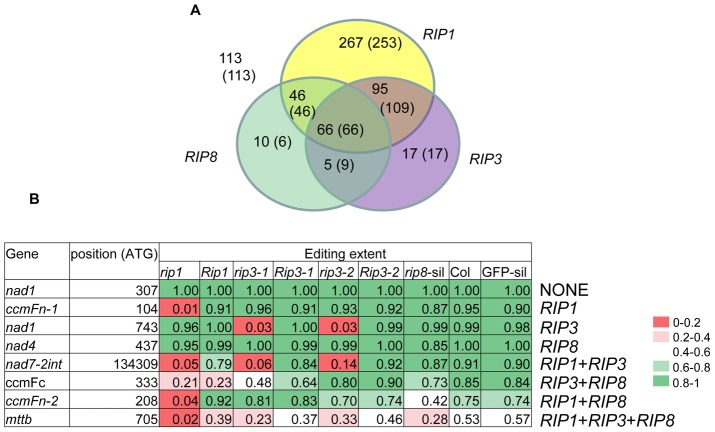
Relative importance of RIPs on mitochondrial editing.(A) Number of mitochondrial sites under the control of RIPs (ΔEE≥0.1, P<1.6 e-6). RIP8 results were obtained from VIGS (all the mitochondrial sites were counted in this analysis). Numbers of sites for RIP3 refer to rip3-1 (rip3-2). (B) Examples of mitochondrial sites falling into one of the eight categories described in the Venn diagram shown in (A). The background color reflects the range of editing extent from red (low: 0–0.2) to dark green (high: 0.8–1).